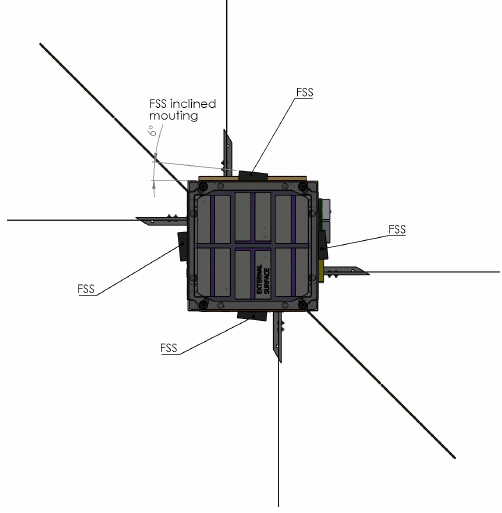
Figure 3. Fine sun sensors’